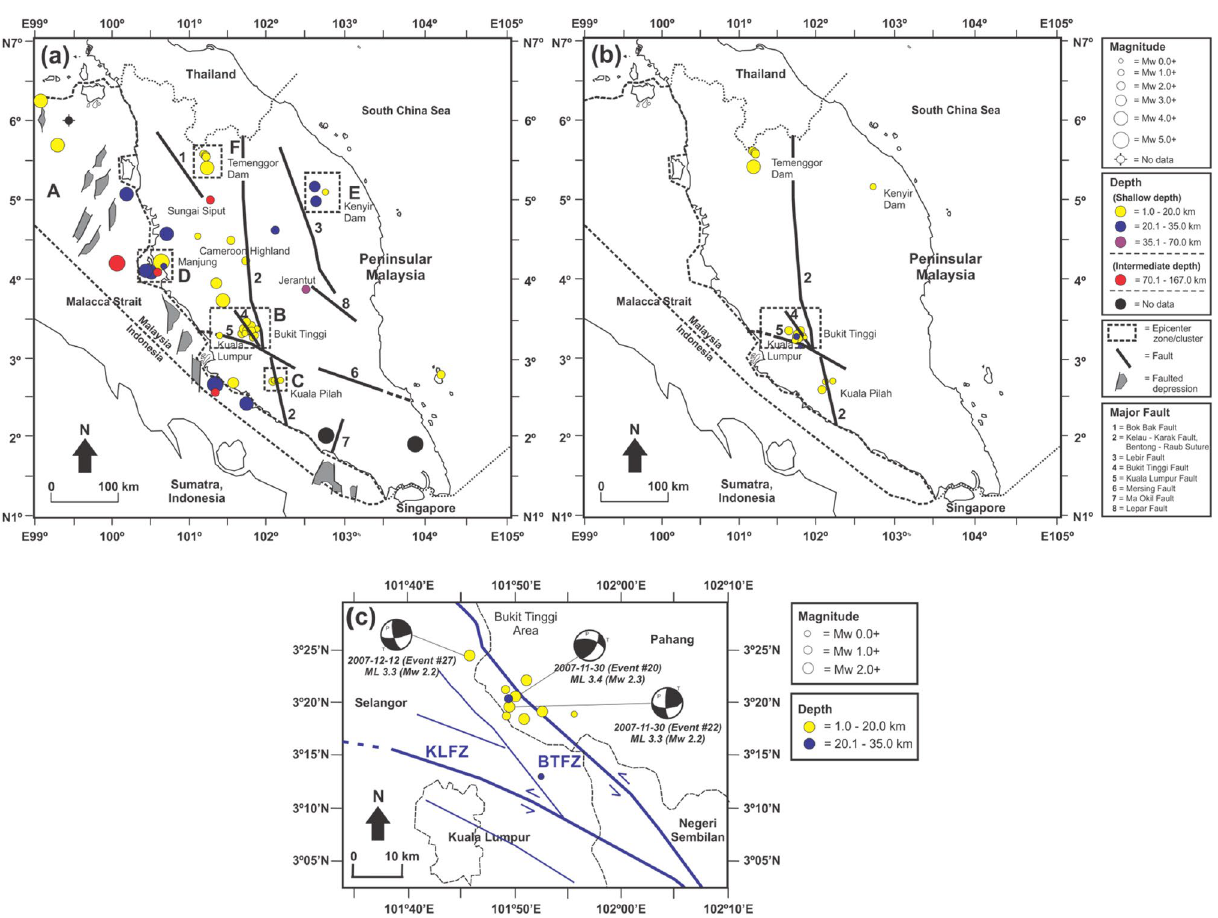
re-analysis of seismograms (obtained from MMD) in this study; and c detailed epicenter distribution of BTFZ and KLFZ as the result of relocation of several local earthquakes with a few focal mecha- nisms determined by [64]; Geological structures onshore and off- shore Peninsular Malaysia were obtained from [20, 21] and [43], respectively; (BTFZ = Bukit Tinggi Fault Zone, KLFZ = Kuala Lumpur Fault Zone). Note: Created with